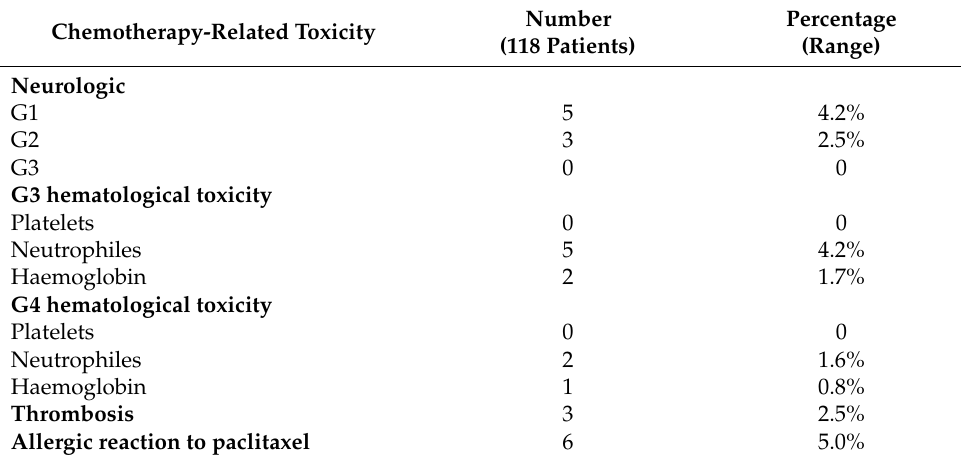
Table 2. Chemotherapy-related